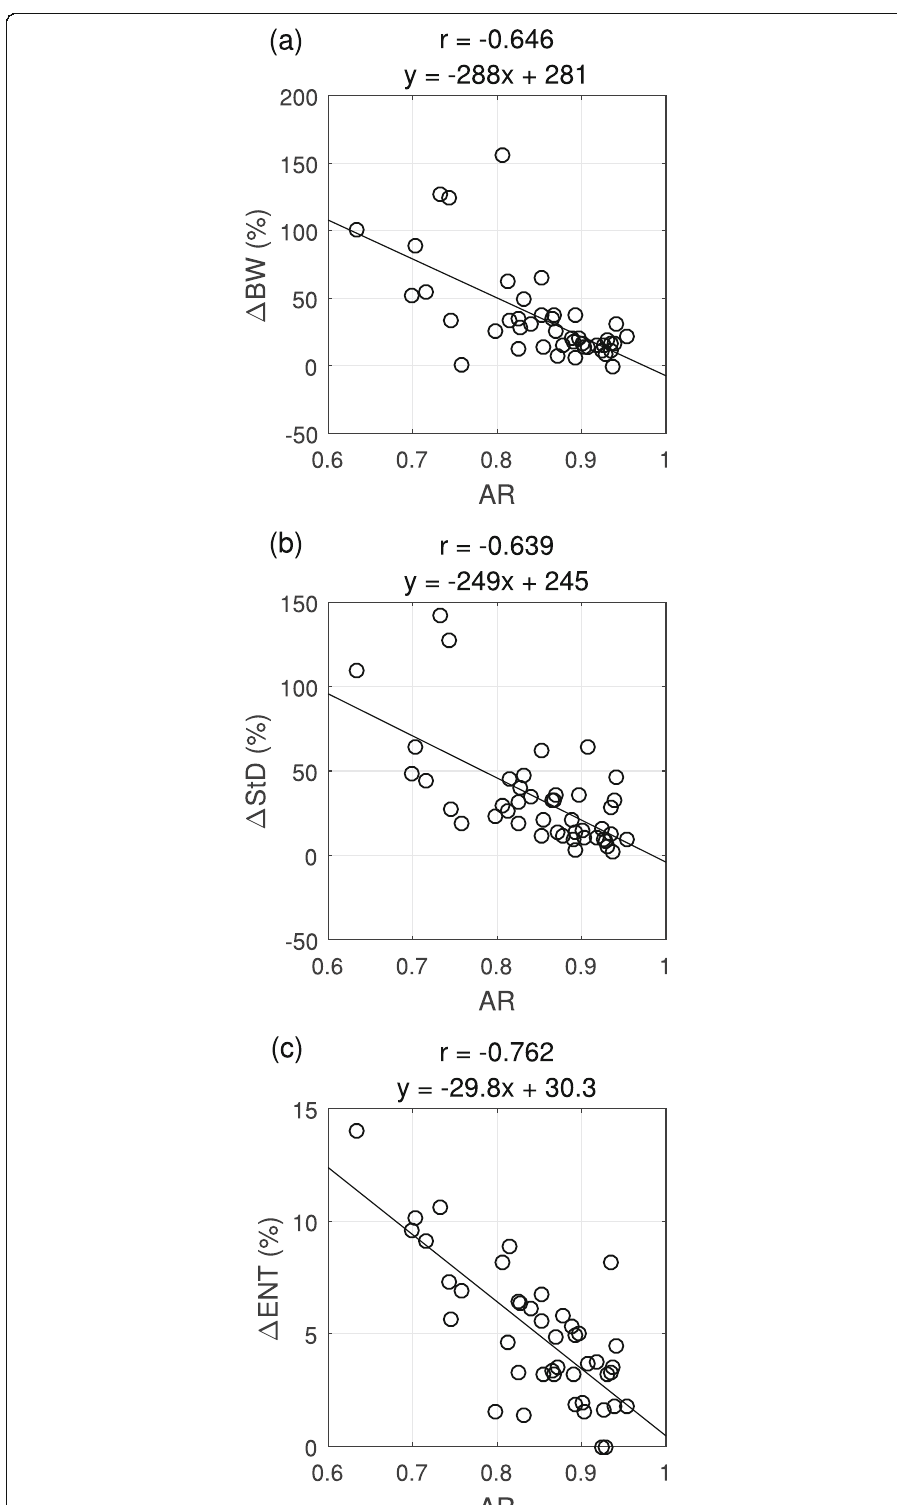
Fig. 3 Scatterplots of activity ratio (AR) vs. changes of bandwidth ( Δ BW), standard deviation ( Δ StD) and entropy ( Δ ENT) between OSEM and TOSEM. Pearson ’ s correlation coefficients ( r ) and regression line equations are